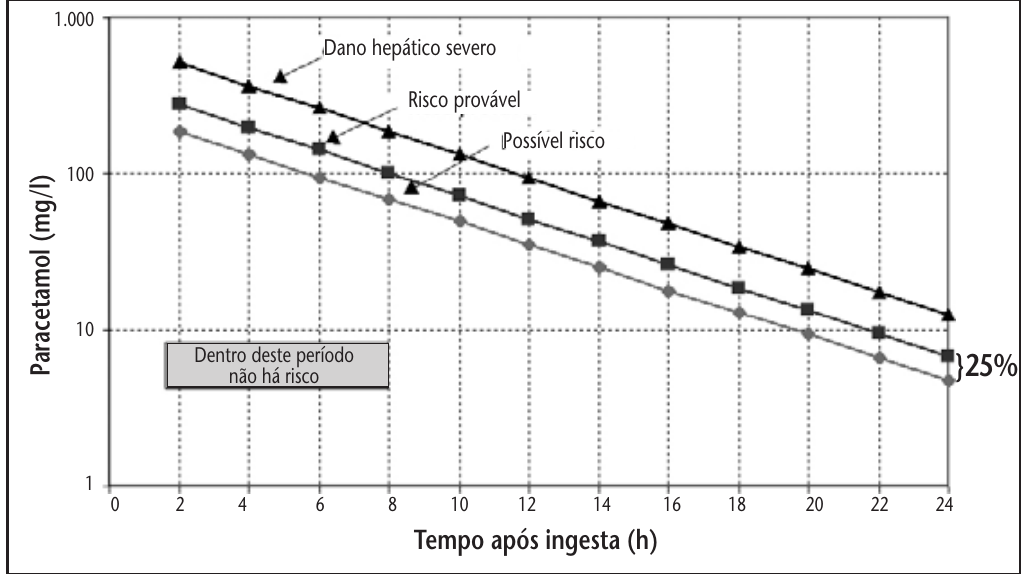
Figura – Nomograma de Rumack-Matthew. É utilizado para indicar a administração do antídoto n-acetilcisteína segundo a concentração plasmática de paracetamol relacionada com o intervalo transcorrido desde a ingesta do medicamento até a coleta do sangue Fonte: Nomograma adaptado da American Academy on Pediatrics